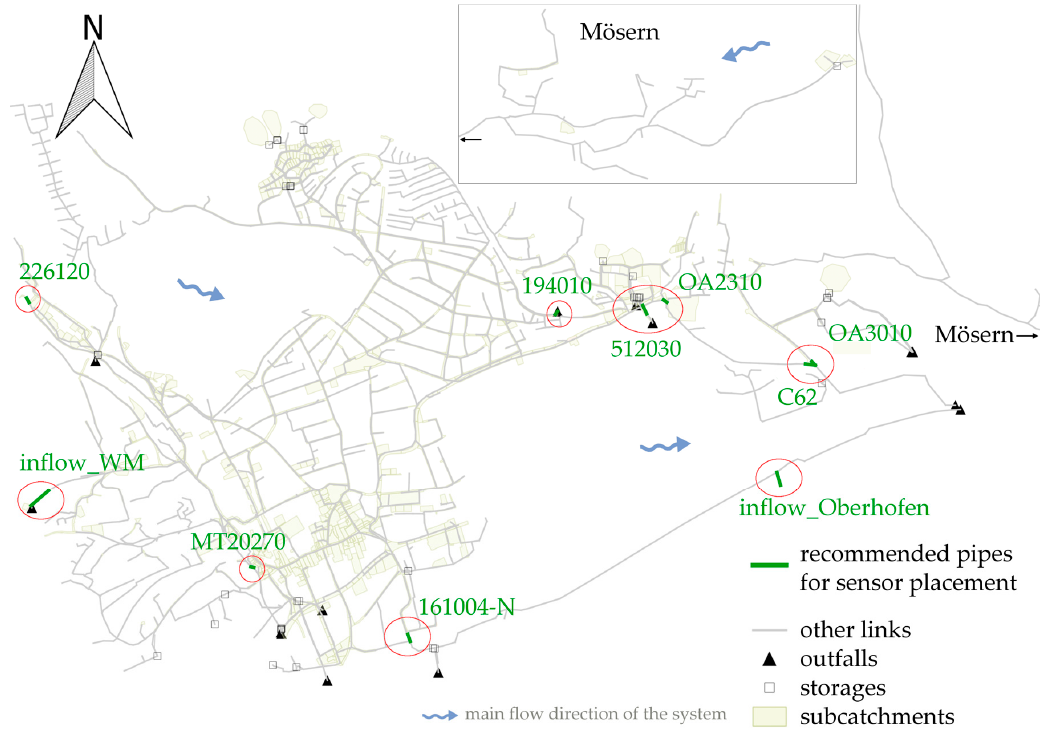
Figure 11. Final recommendations for measurement sites (encircled in red).